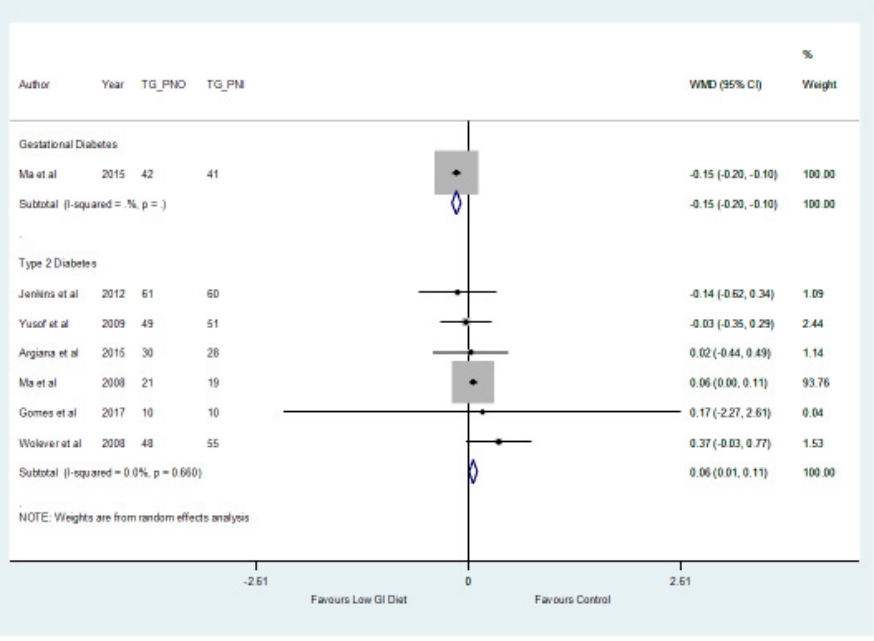
Figure 6. A forest plot depicting the effect of a low GI diet on Total Cholesterol (mmol/L).